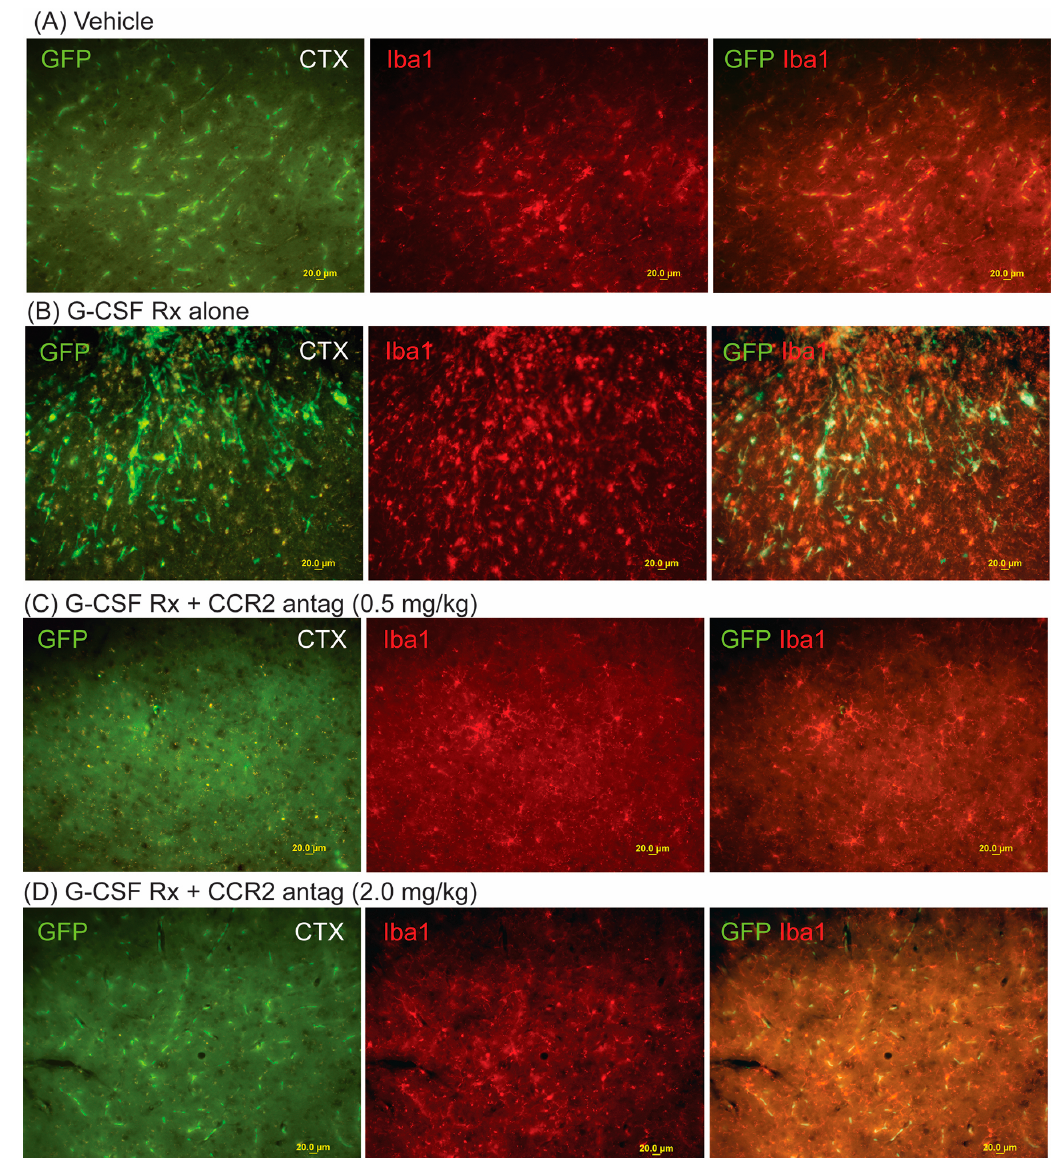
Figure 1. Effects of right-sided controlled cortical impact (CCI) on microgliosis (Iba1+ cells) and infiltration of green fluorescent protein-expressing (GFP+) cells into the right cerebral cortex at two weeks. The left-hand panels show GFP+ cells; middle panels show Iba1+ cells (microglia); right-hand panels show the composite image (GFP/Iba1). ( A ) Effects of vehicle treatment; ( B ) effects of granulocyte colony-stimulating factor (G-CSF) (100 µg/kg daily × 3 days) treatment after CCI. Note that many microglia co-express GFP+, indicating their origin from peripheral monocytes; ( C ) Effect of G-CSF and CCR2 antagonist treatment (0.5 mg/kg daily × 3 days); ( D ) effects of G-CSF and CCR2 antagonist treatment (2.0 mg/kg daily × 3 days) (scale bar = 20 µm).